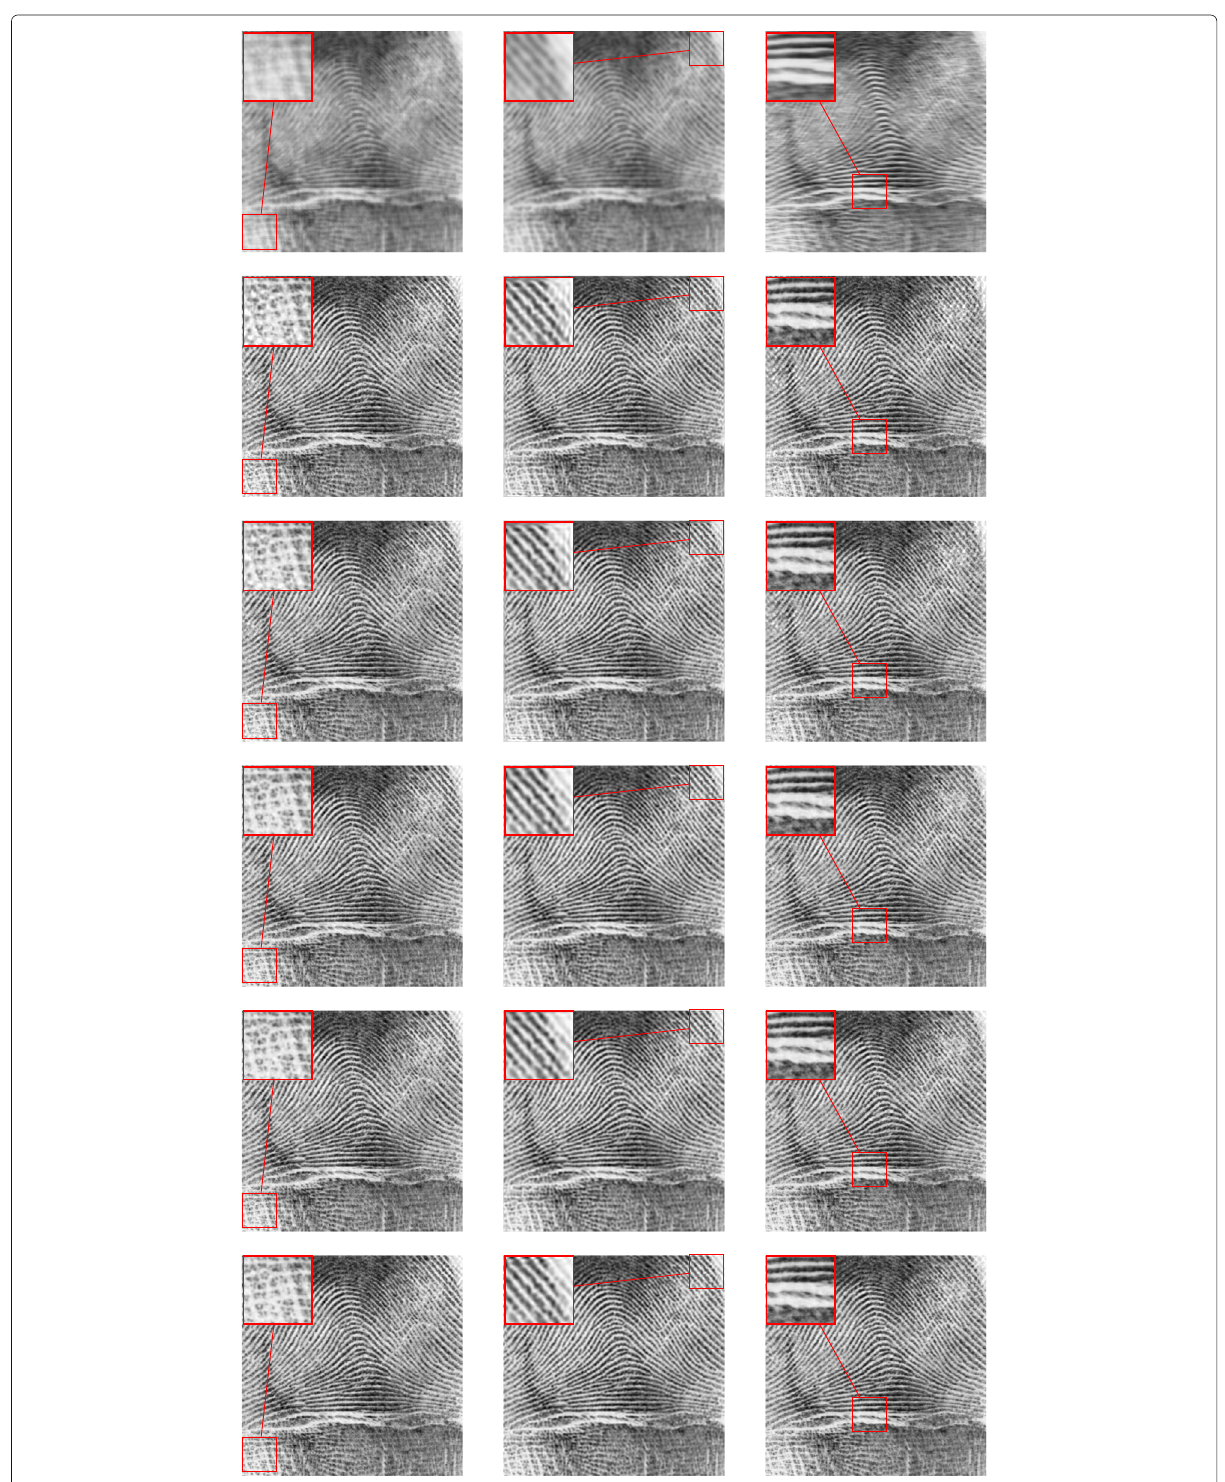
Fig. 9 Deconvolution of Fingerprint image. From left to right, the first column represents degradation by kernel 1, the second column for the degradation by kernel 2, and by kernel 3 in the third column. From top to bottom, the order of the rows is as follows: blurred images using the three kernels respectively, restored images using RL algorithm [11] (kernel 1 (iterations = 100), kernel 2 (iterations = 240), and kernel 3 (iterations = 90)), restored images using Wiener filter [9], restored images using TV method [14], restored images using BTV approach [16], and finally the restored images using our proposed MAP- H 1